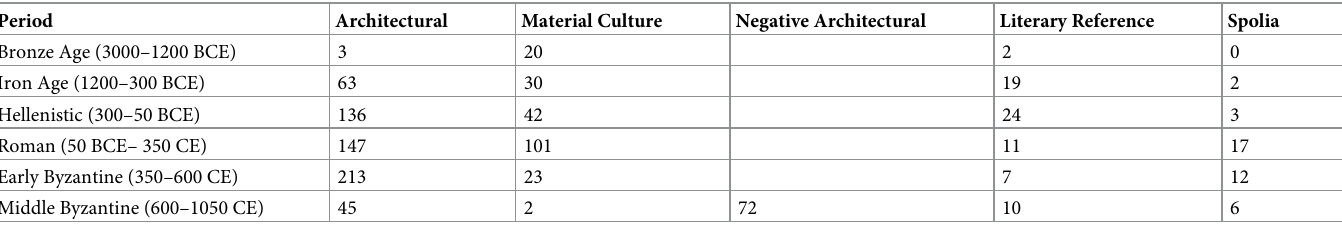
Table 2. Settlement evidence by